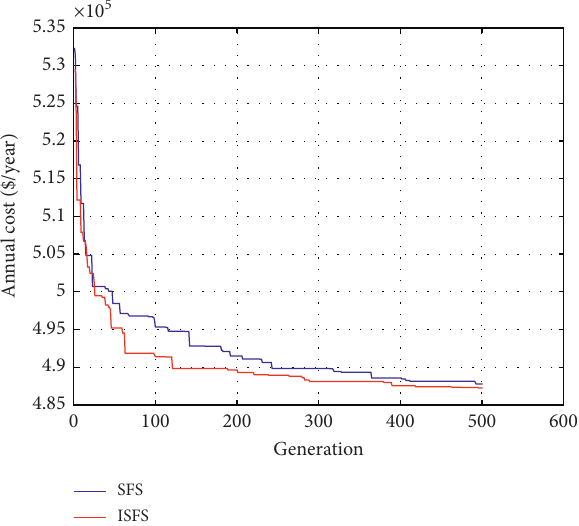
Figure 18: Convergence characteristics of annual cost for 119-bus network with 100% loading in scenario 1.